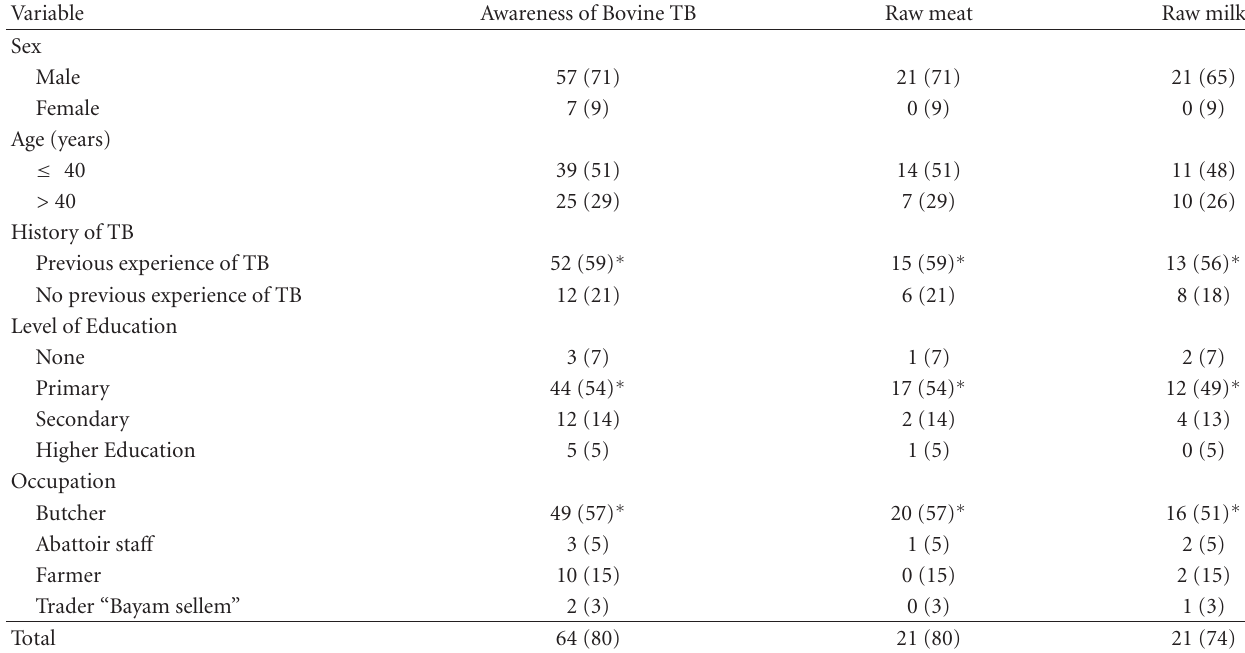
Table 3: Factors a ff ecting cattle handlers’ awareness of bovine tuberculosis and their consumption of raw beef and raw milk. Variable Awareness of Bovine TB Raw